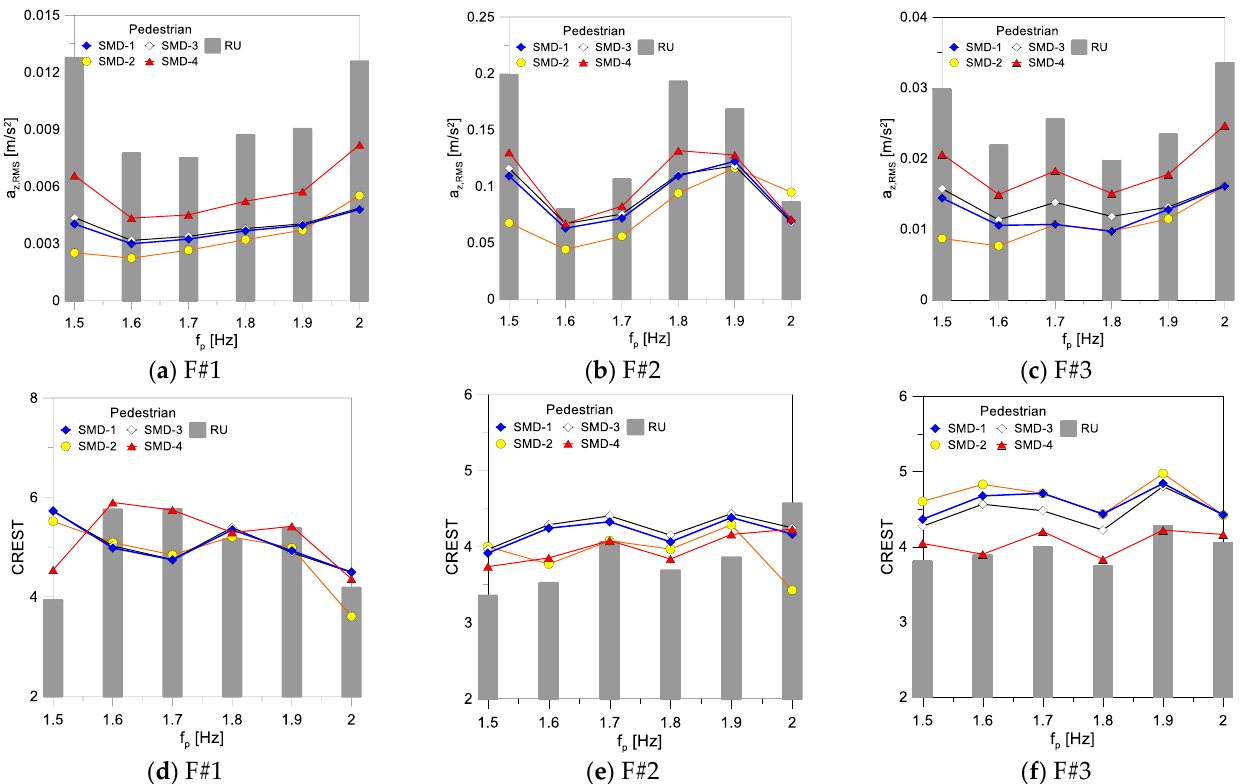
Figure 8. Numerical results for F#1, F#2 (concrete) and F#3 (glass) systems, based on different SMD or RU calculations, in terms of ( a – c ) RMS acceleration or ( d – f ) CREST factor, as a function of walking frequency f p (ABAQUS).